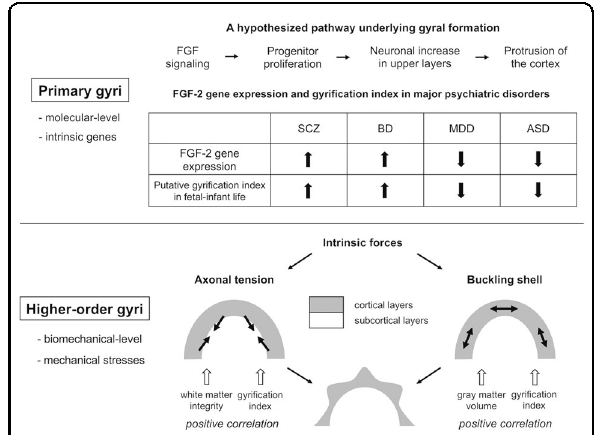
Fig. 3 Assumed mechanisms of brain gyri fi cation. Upper: Molecular-level mechanisms in primary gyri (mainly affected by intrinsic genes). Below: Biomechanical-level mechanisms in higher- order gyri (mainly affected by mechanical stress). ASD autism spectrum disorder, BD bipolar disorder, FGF fi broblast growth factor, MDD major depressive disorder, SCZ